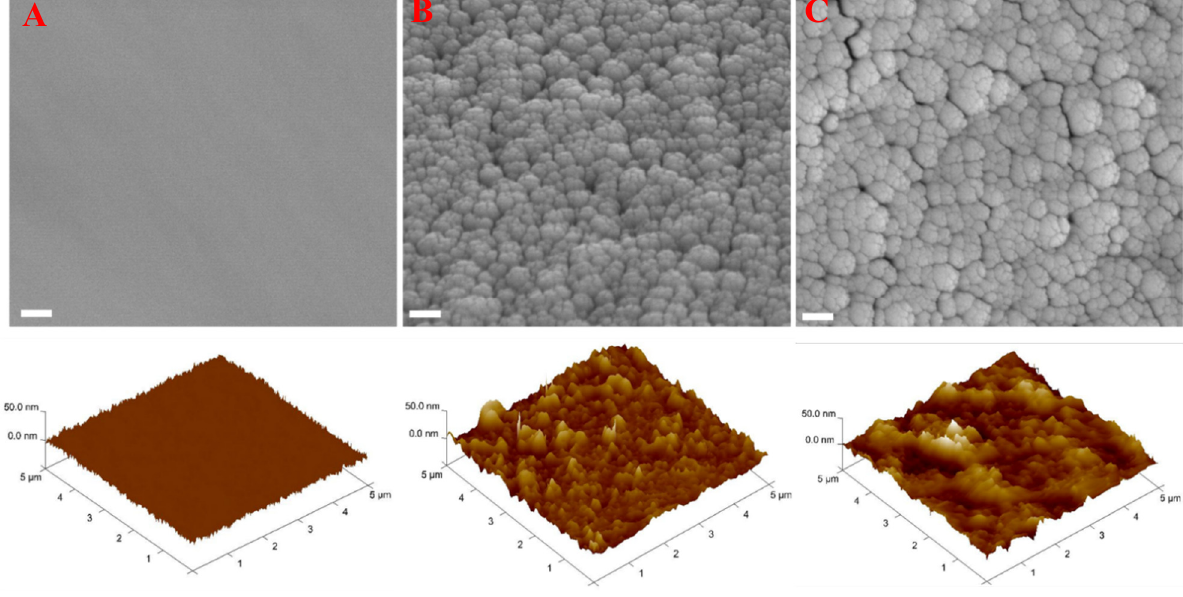
Figure 1. FESEM and AFM images of ( A ) Chitosan, ( B ) Chitosan-MgO 5 wt.% and ( C ) chitosan-MgO 10 wt.%. The scale bare for FESEM is 100 nm.